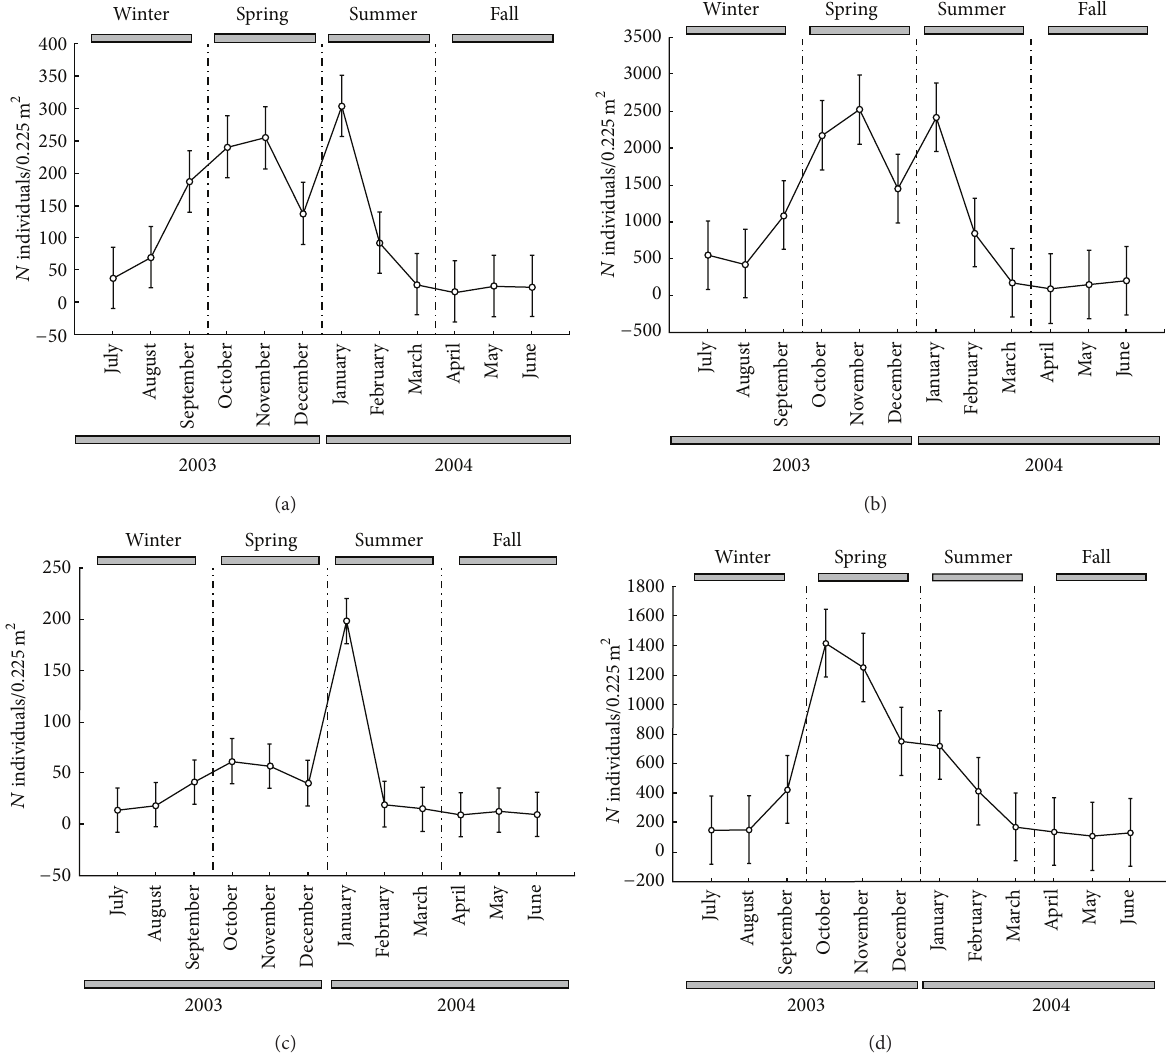
Figure 5: Monthly variation in the mean density of Monokalliapseudes schubarti per 0.225 m 2 , of Saco da Fazenda, during the period from July 2003 to June 2004: (a) males; (b) females; (c) ovigerous females; (d) juveniles (mean ± standard